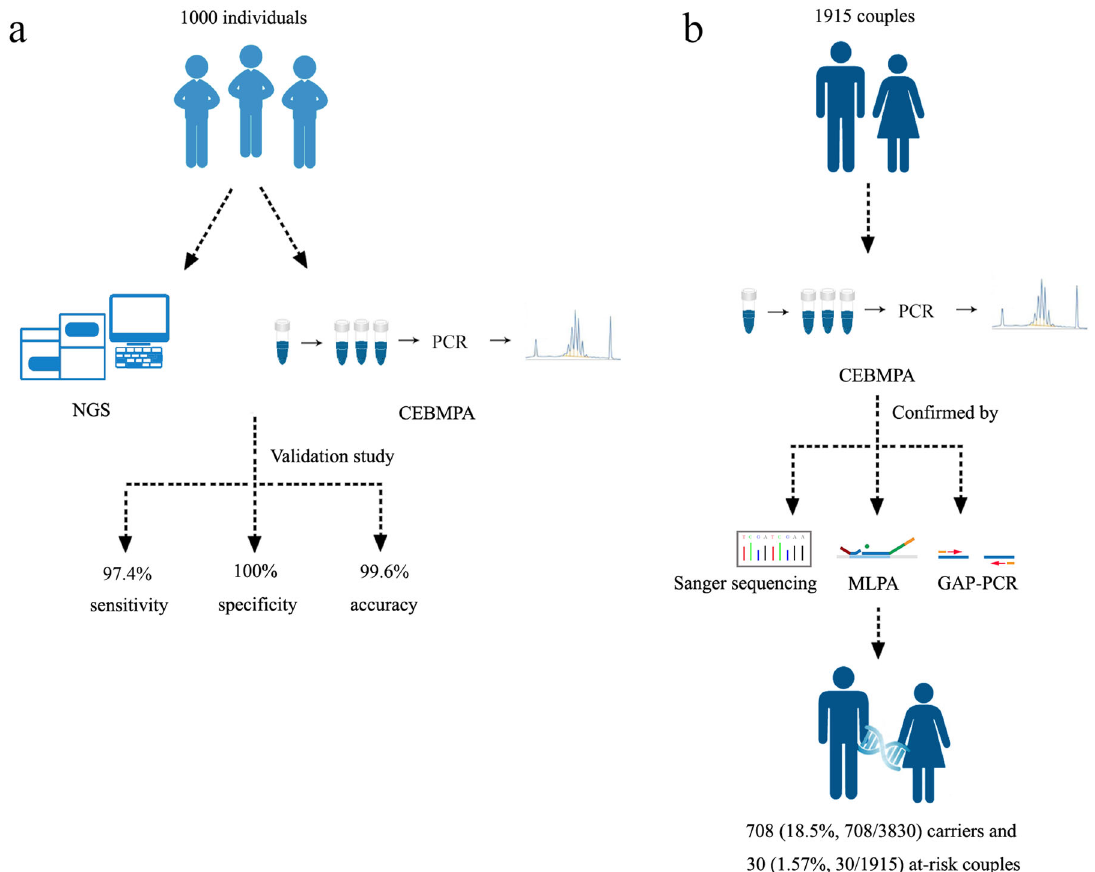
Fig. 1 The fl ow diagram depicts the recruitment of participants and methods used for screening. Two participant cohorts were used in this study. a The fi rst participant cohort consists of 1000 individuals, who were detected in parallel with NGS and CEBMPA to validate the sensitivity and speci fi city of CEBMPA. b The second cohort including 1915 couples (3830 individuals) were detected with CEBMPA. All detected variants were con fi rmed by alternative methods, such as Sanger sequencing, multiplex ligation-dependent probe ampli fi cation, or Gap-PCR.